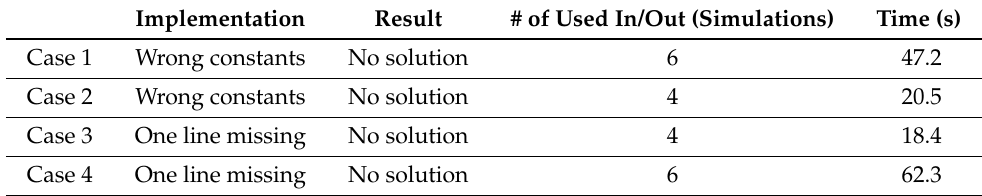
Table 3. Experimental results for four cases.